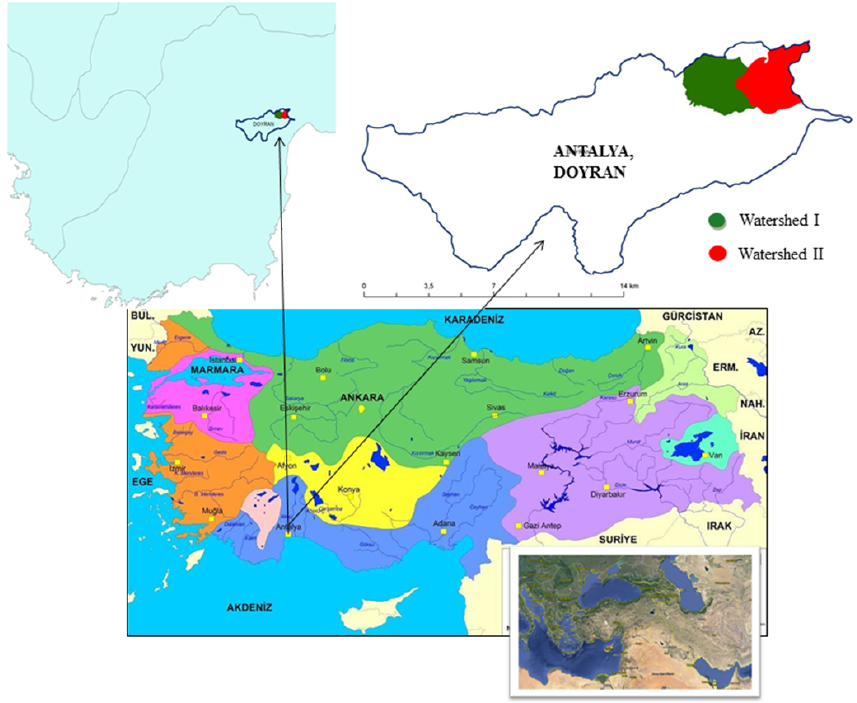
Figure 1. Location of the study area in Antalya,